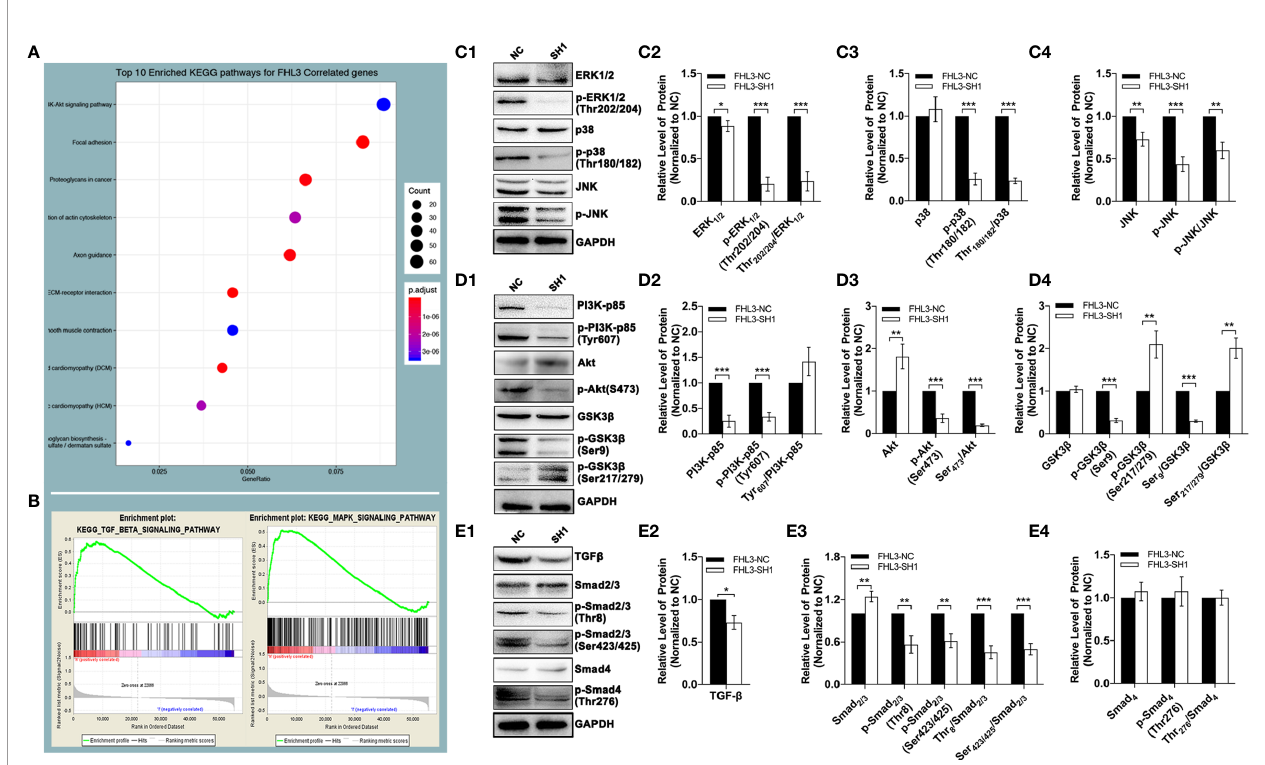
FIGURE 7 | The genetic characteristics and pathways ’ activation by FHL3 knockdown. (1) In KEEG and GO analyses, MAPK, PI3K/Akt and TGF b pathways are related to FHL3 (A, B) ; (2) The expression and activation levels of MAPK pathway proteins were detected by western blot: down-regulation of ERK1/2, Thr202/204-ERK 1/2 (p- ERK 1/2 ), p-ERK 1/2 /ERK 1/2 and Thr180/182-P38 and p-P38/P38 by FHL3 knockdown was observed (C 1 – 4 ) ; (3) The expression and activation levels of PI3K pathway proteins were detected: down-regulation of PI3K-p85, Tyr607-PI3K-p85 (p-PI3K), S473-Akt (p-Akt), p-Akt/Akt, Ser9-GSK3 b and Ser9-GSK3 b /GSK3 b , and up-regulation of Akt, Ser217/279-GSK3 b and Ser217/279-GSK3 b /GSK3 b by FHL3 knockdown were observed (D 1 – 4 ) ; (4) The expression and activation levels of TGF b pathway proteins were detected: down-regulation of TGF b , Thr8-Smad 2/3 (p-Smad 2/3 ), Ser423/425-Smad 2/3 (p-Smad 2/3 ), and p-Smad 2/3 /Smad 2/3 by FHL3 knockdown were observed, while the status of Smad 4 was not signi fi cantly affected by FHL3 (E 1 – 4 )